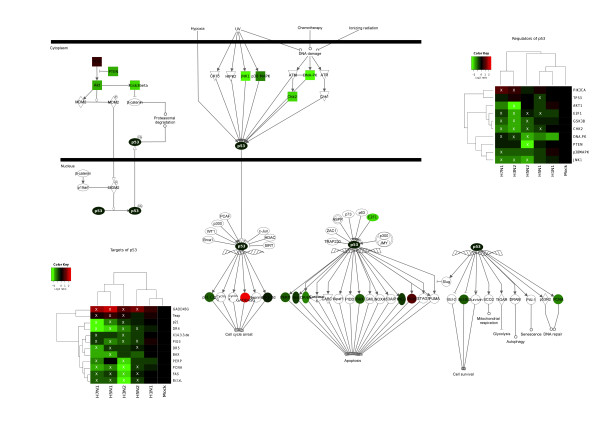
Transcriptional regulation of the genes belonging to the p53 signalling pathway (IPA canonical pathway) during influenza viral infection. Mean fold changes of the genes encoding regulators and targets of p53 that were differentially expressed by at least one virus, calculated as Log2(Mean expression levels in infected samples) - Log2(Mean expression levels in mock samples) and overlaid on the pathway in green for downregulated genes (FC < 0), and red for upregulated genes (FC > 0). Fold changes in each group of samples are depicted in the heat maps and were used to cluster hierarchically both samples and genes. Genes considered significant for each virus with the SAM procedure are indicated by a white X on the heat maps.